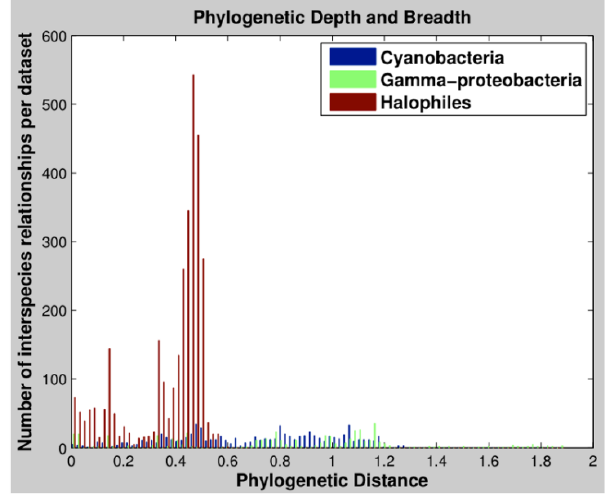
Figure 1. Comparative phylogenetic depth and breadth of datasets used in OLS comparison analyses. Phylogenetic distances were determined between all organisms used in two previous cross-species OLS comparisons analyses as well as the organisms we used in this study (see Methods). The organisms used in our investigation (“halophiles”, red) offer less breadth than those used in previous studies (“cyanobacteria”, blue, and “gamma-proteobacteria”, green), however, provide significantly more depth. This additional depth allows us to observe many more types of OLS modification, and increases the confidence with which report our results.